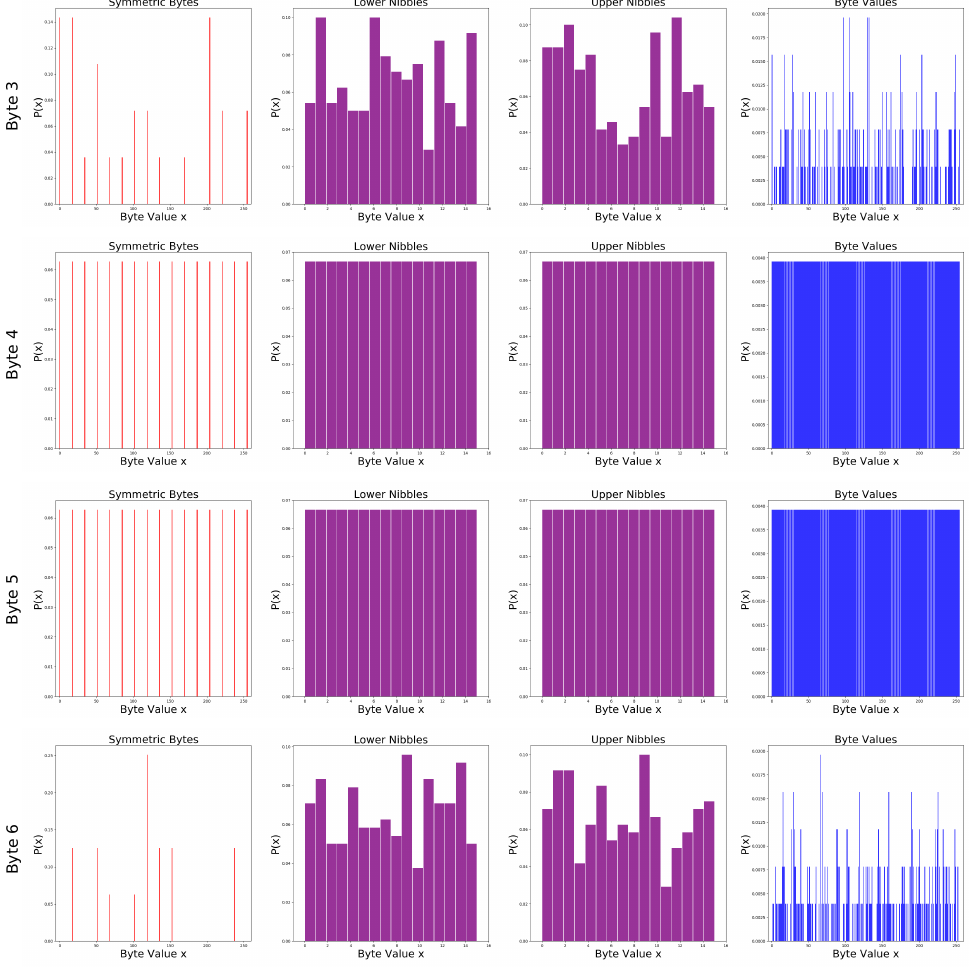
Figure 8: Histograms demonstrating the integral cryptanalytic technique which we apply in Section 5.4. Each histogram represents the cyphertext byte values which are output at a specific byte index over a set of adversarially chosen plaintexts. Ciphertext byte indices 3, 4, 5 and 6 are shown along the y-axis. The x-axis is composed from left-to-right showing the symmetric byte values, the lower nibble values, the upper nibble values and finally the complete byte values. This method of presenting the ciphertexts allows the permutation key part to be divide and conquered. In this case byte indices 4 and 5 are exposed by their uniform byte distributions as originating from the first two rounds of